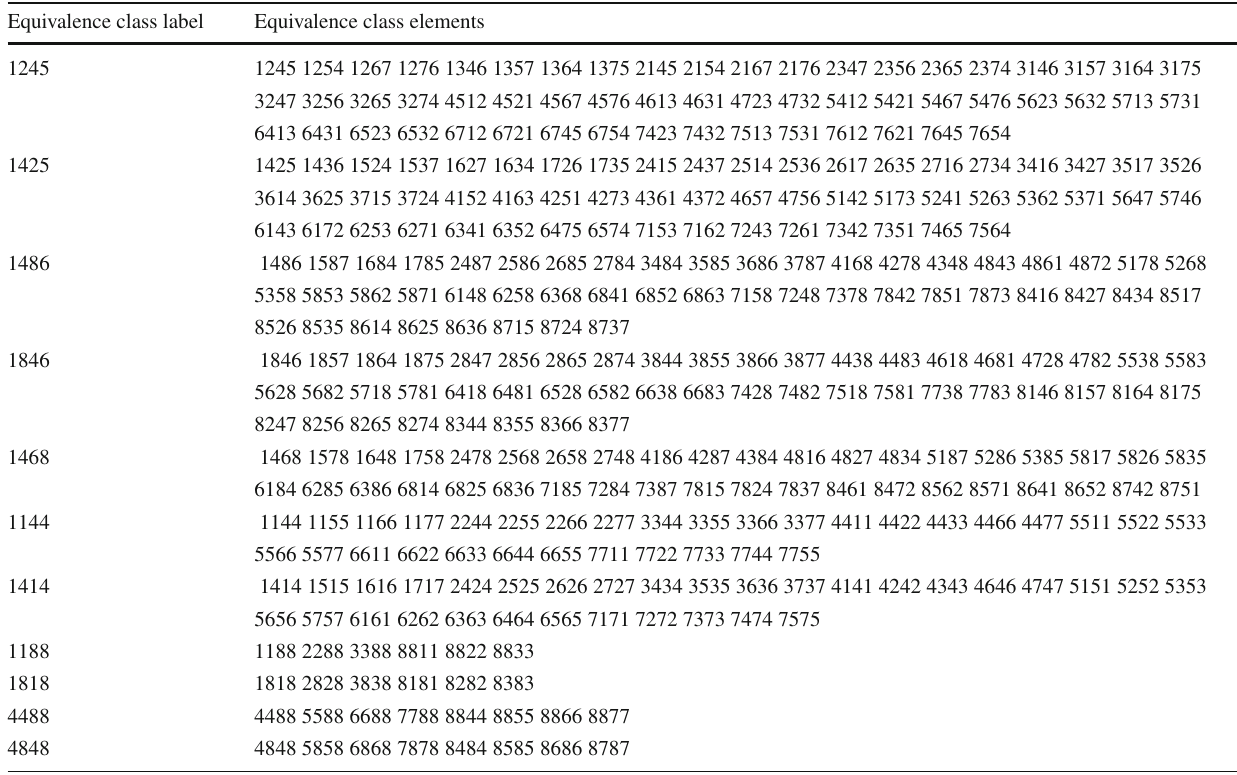
Table 2 Ward identities WI( abcd ) grouped into equivalence classes. Each class is labeled by four flavour indices abcd , of a representative element, listed in the leftmost column. All elements of the same class are grouped to the right. For more explanations, see text Equivalence class label